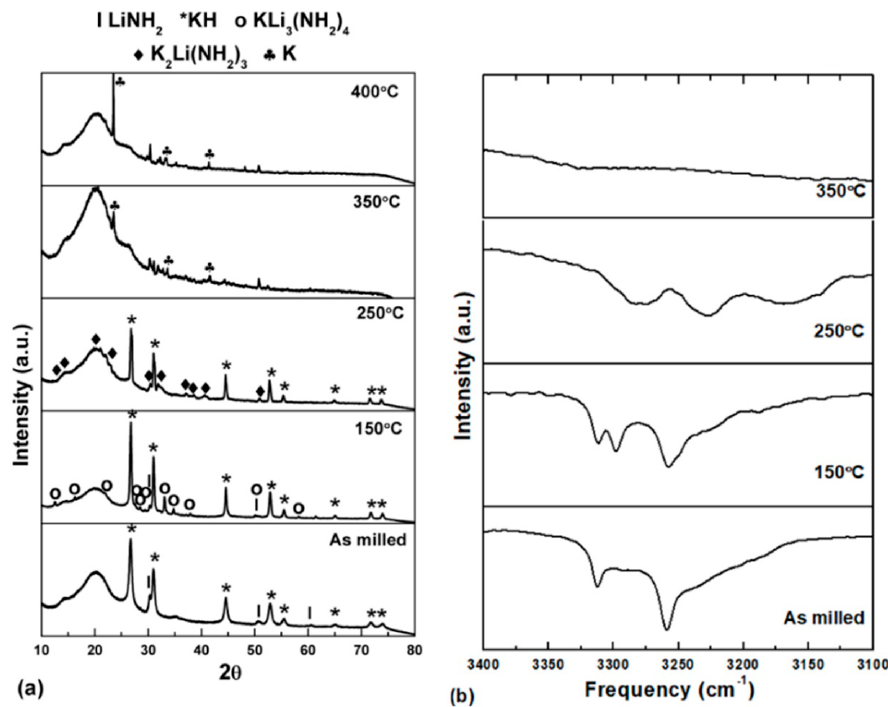
Figure 2. ( a ) XRD pattern and ( b ) FTIR spectra of LiNH 2 and KH milled sample at different temper ‐ atures.